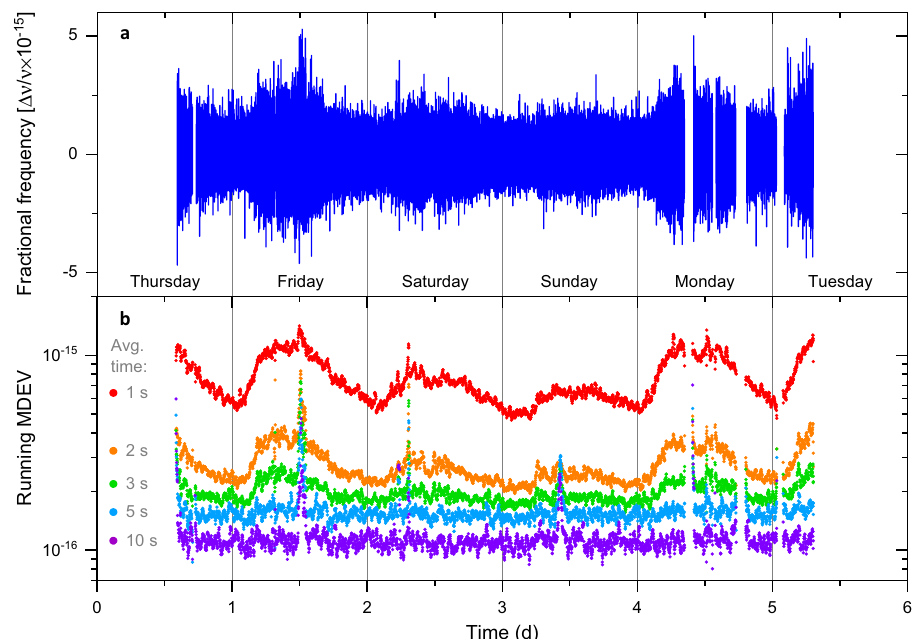
Fig. 3 Ultrastable laser comparison as a means of extracting the total fi bre link noise as a function of time. a Frequency comparison of distant ultrastable lasers (data taken in July 2019). A high-pass fi lter with a cut off frequency of 1 mHz is used to decouple the short-term instability of the optical fi bre link from the drift of the ultrastable lasers (with a characteristic time >1000 s). b The total phase-stabilised 2220 km fi bre link residual noise as a running instability of the high-pass fi ltered comparison of ultrastable lasers, calculated using data sets of duration 1000 s for 1 s to 10 s averaging time. The variations in environmental noise picked up along the fi bre over six consecutive days of continuous operation can be resolved for 1 s averaging time. The days of the week are shown to highlight the correlation with human activity. Comparison noise averages down to 1 ´ 10 (cid:2) 16 instability at 10 s integration time. The spikes in instability are glitches in the link